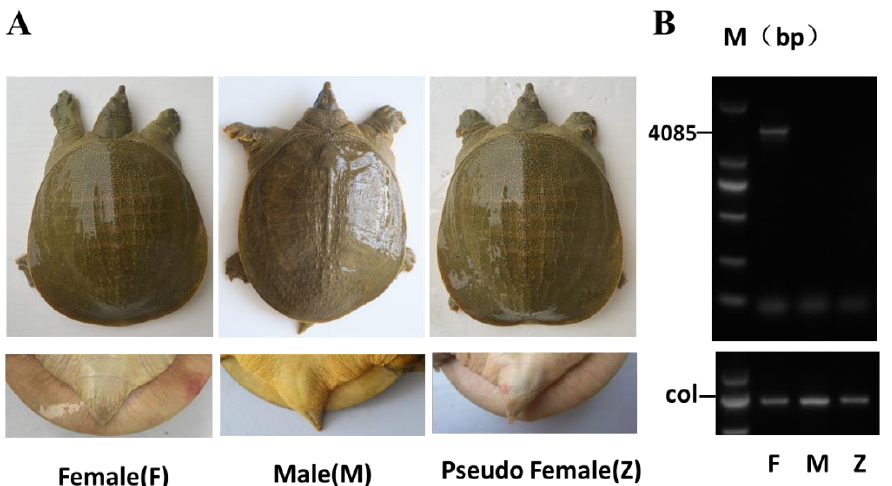
Figure 1. Pseudo-female Chinese soft-shelled turtles were obtained by E2 treatment: ( A ) Pseudo- female of Chinese soft-shelled turtles were obtained by E2 treatment. ( B ) Verification of three phenotypes by PCR. F: female, M: male, Z: pseudo-female.